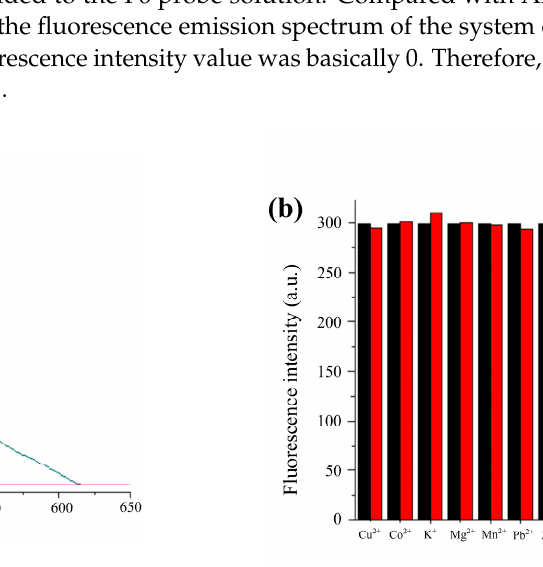
Figure 5. ( a ) Metal ion selectivity study; ( b ) Anti-interference study of fluorescent systems.